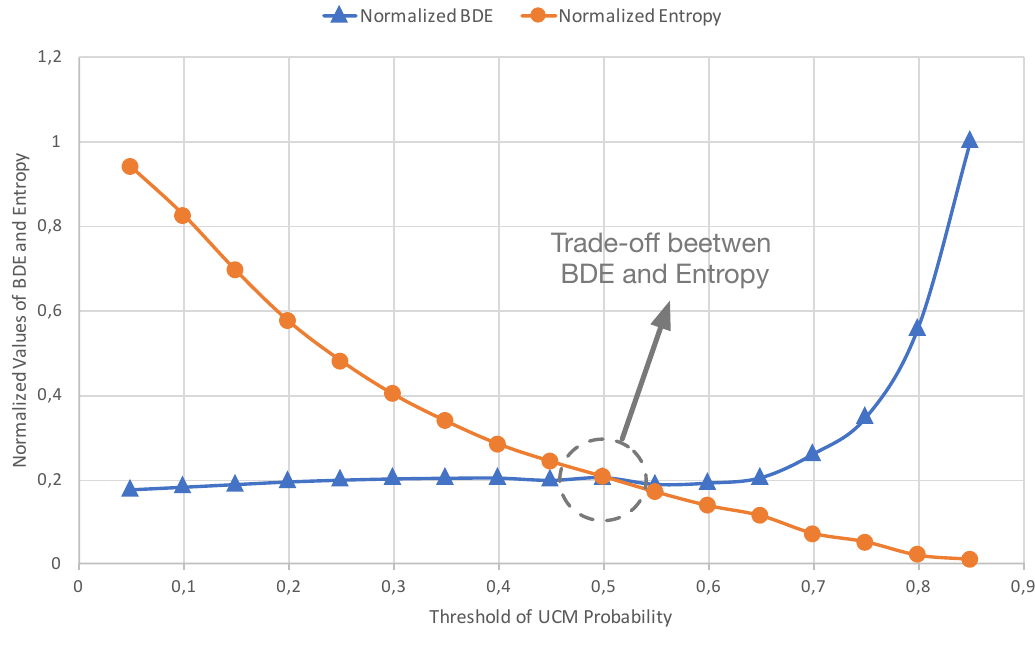
Figure 7. Representation of error versus the edge entropy for different threshold values.